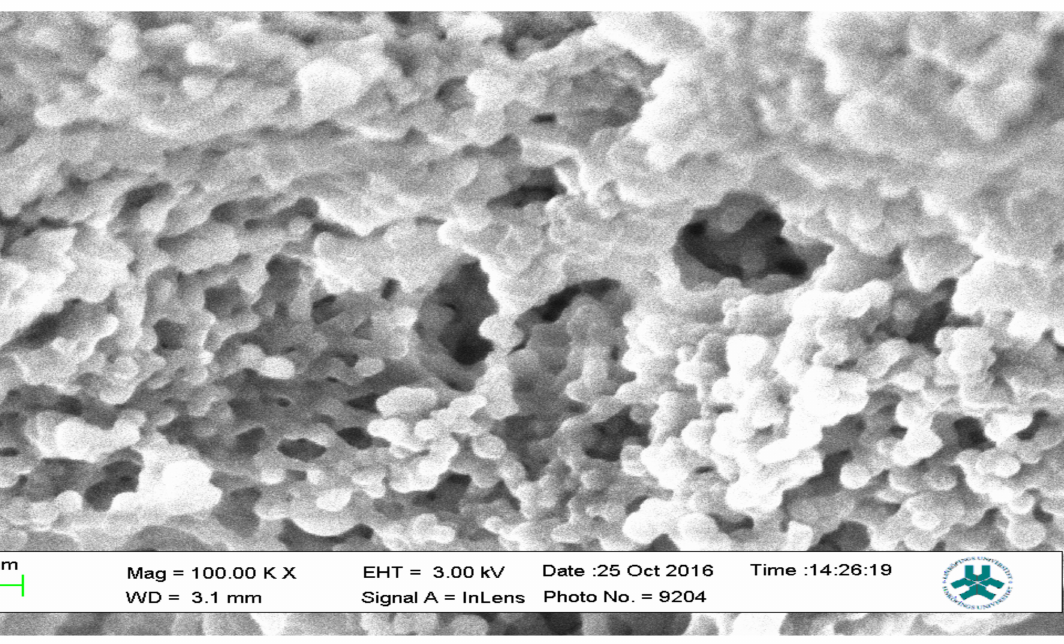
Figure 12. SEM micrograph of the 3-Phenylpiridine